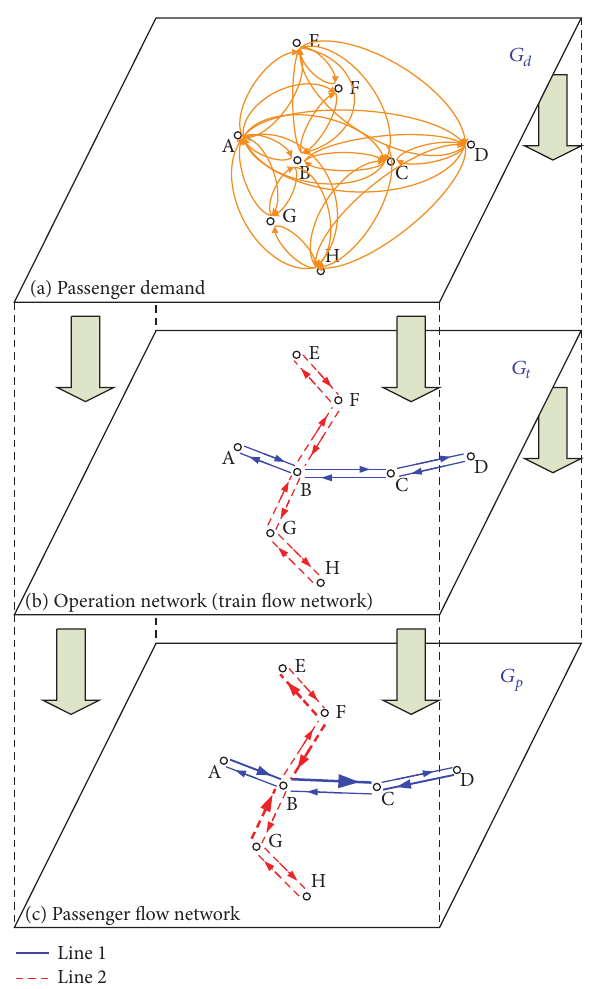
Figure 2: Schematic representation of an example of (a) the passenger transport demand of the subway infrastructure network with 𝑁 nodes and 𝑁(𝑁 − 1) edges, (b) the train flow network with 𝑁 nodes and 𝐸 edges, and (c) the corresponding passenger flow network with 𝑁 nodes and 𝐸